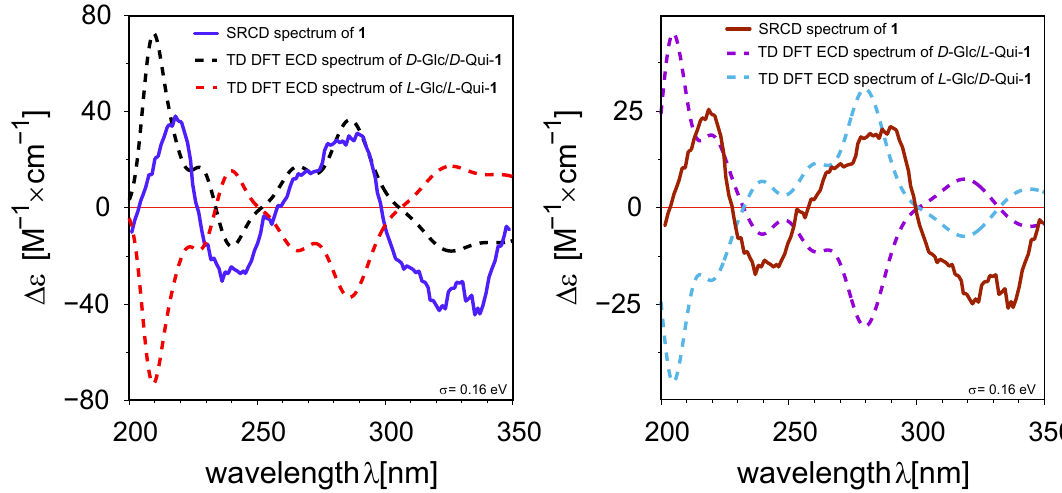
Figure 4. Overlay of synchrotron radiation circular dichroism (SRCD) and TD DFT spectra of 1 .